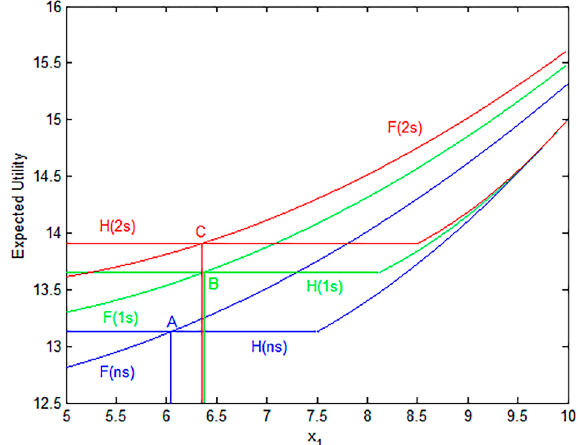
Figure 4. Evolution of thresholds for a risk-neutral DM given uniform beliefs and signals on X 1